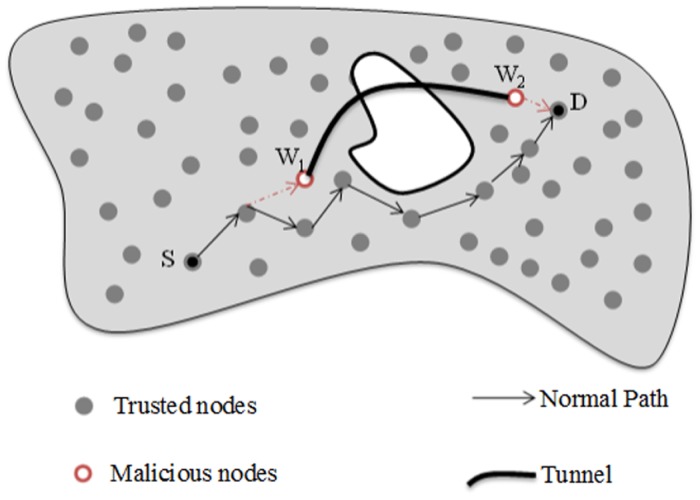
The wormhole attack.